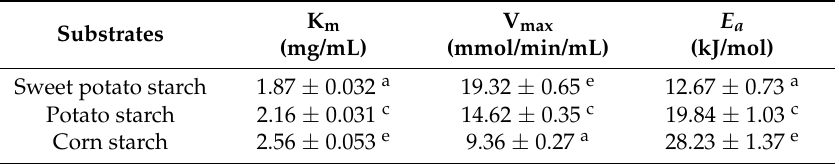
Table 3. Kinetic and activation energy parameters of Mal-mPEG5000-SPA.